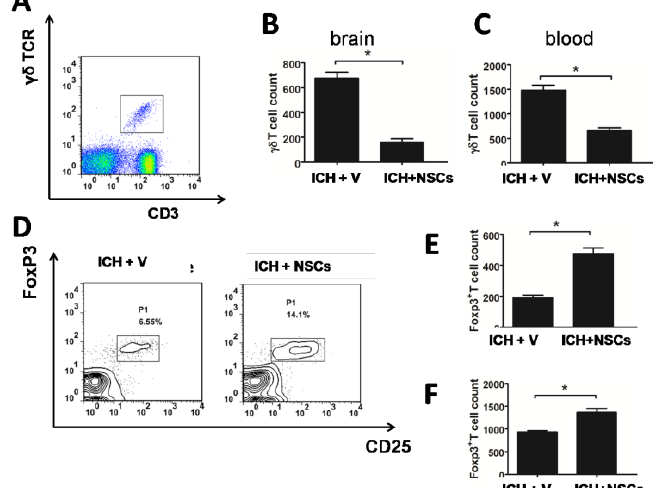
Figure 4. Transplanted NSCs altered γδT and Treg cells in the brain and peripheral blood. Transplanted NSCs reduced the absolute numbers of γδT cells in the brain and peripheral blood ( A – C ); The percentage and the absolute numbers of Treg cells were significantly increased in the brain by transplantation of NSCs ( D , E ); An increased absolute Treg cell numbers in the peripheral blood after transplanted NSCs ( F ). ( n = 8 in each group) * p < 0.05 versus